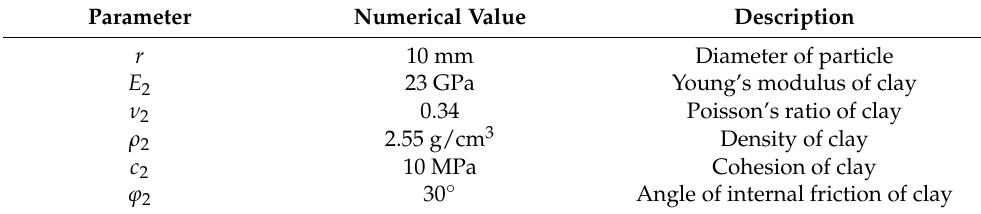
Table 4. Related parameters of the rock